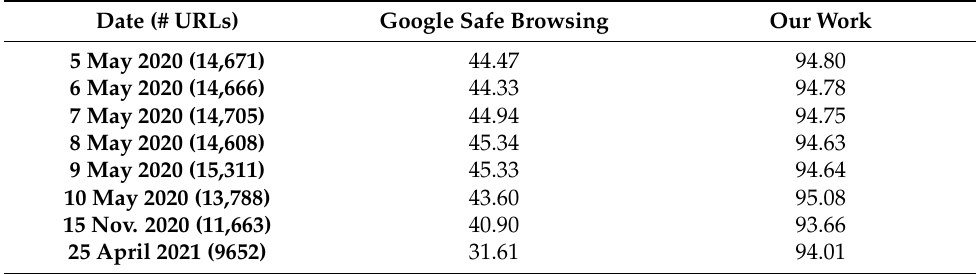
Table 7. Evaluation of accuracy over time using